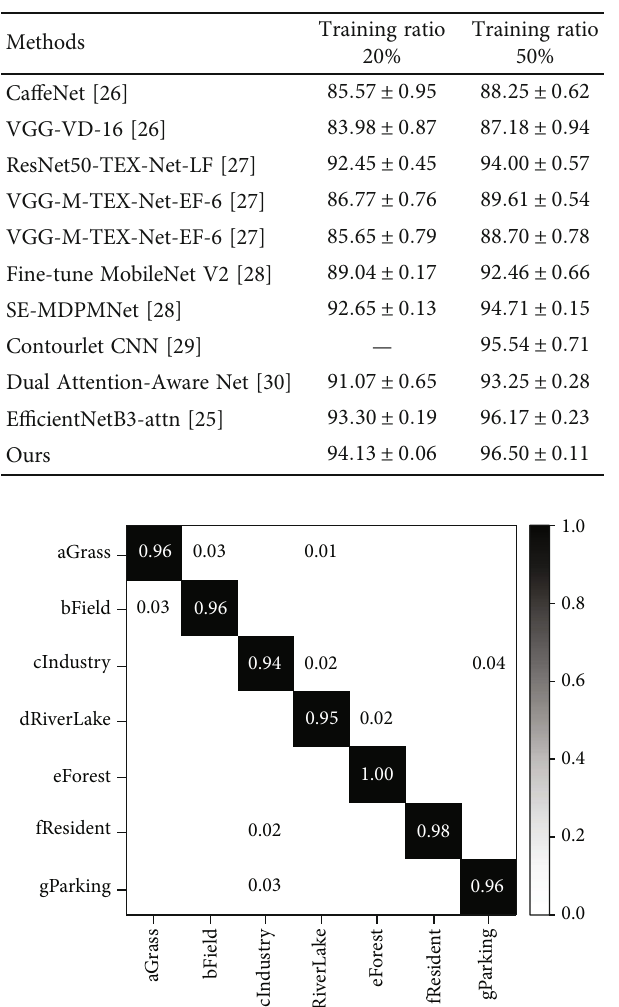
Table 4: Overall accuracy (%) comparison with other methods on the RSSCN7 data